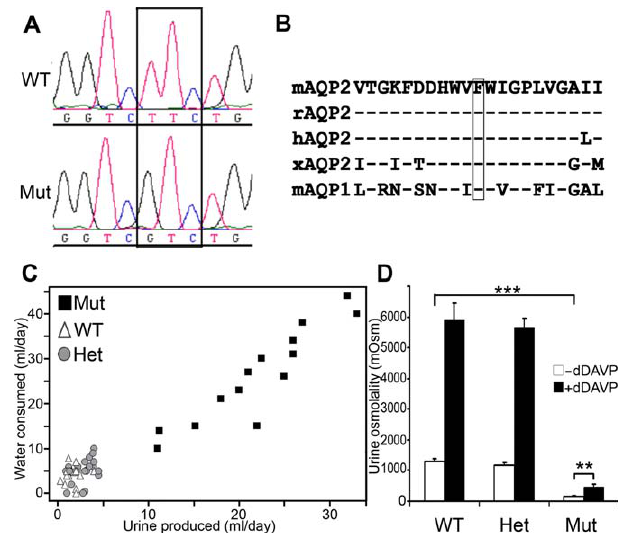
Figure 1. Analysis of Aqp2 Sequence and Phenotype in Mutant Mice (A) Chromatographic traces of Aqp2 F204V mutation. The box shows the mutated codon, TTC (Phe) to GTC (Val) at position 204. WT, wild type; Mut, mutant. (B) Amino acid conservation of mouse AQP2 (residues 194–214). The boxed residue indicates phenylalanine at position 204. hAQP2, human AQP2; mAQP1, mouse AQP1; mAQP2, mouse AQP2; rAQP2, rat AQP2; xAQP2, Xenopus AQP2. (C) Urine production (ml) and water consumption (ml) of 58 F2 mice over a 24-h period (both sexes, aged 10–22 wk). Mutant mice (black squares) exhibit overt polyuria and polydipsia compared to littermate wild-type (white triangles) and heterozygous (grey circles) mice. (D) Urine osmolality and concentrating ability in Aqp2 mutant and their littermates (10–22 wk, both sexes), before (white bars) and after (black bars) dDAVP treatment. Wild type (WT; n ¼ 12); heterozygote (Het; n ¼ 20); mutant (Mut; n ¼ 9). Data represent averages 6 standard error of the mean, ** p , 0.01; *** p , 0.001. DOI: